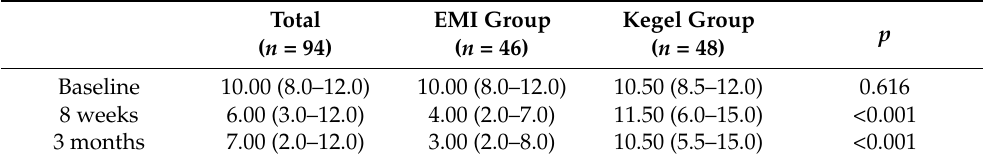
Table 6. Analysis of the three-day bladder diary in the study population and between the observed groups throughout the follow-up